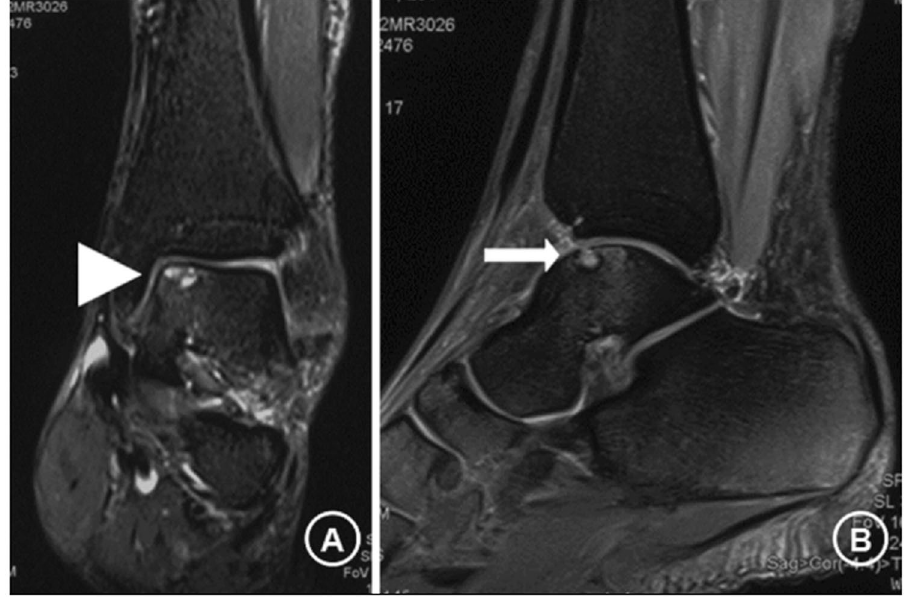
Figure 2. T2-weighted coronal ( A ) and sagittal ( B ) magnetic resonance images of the ankle. The images confirm the presence of subchondral osteochondral lesions ( A , arrow head; B , arrow) of the talus with apparent intact cartilage. Note: The patient consented to publish the specific information.